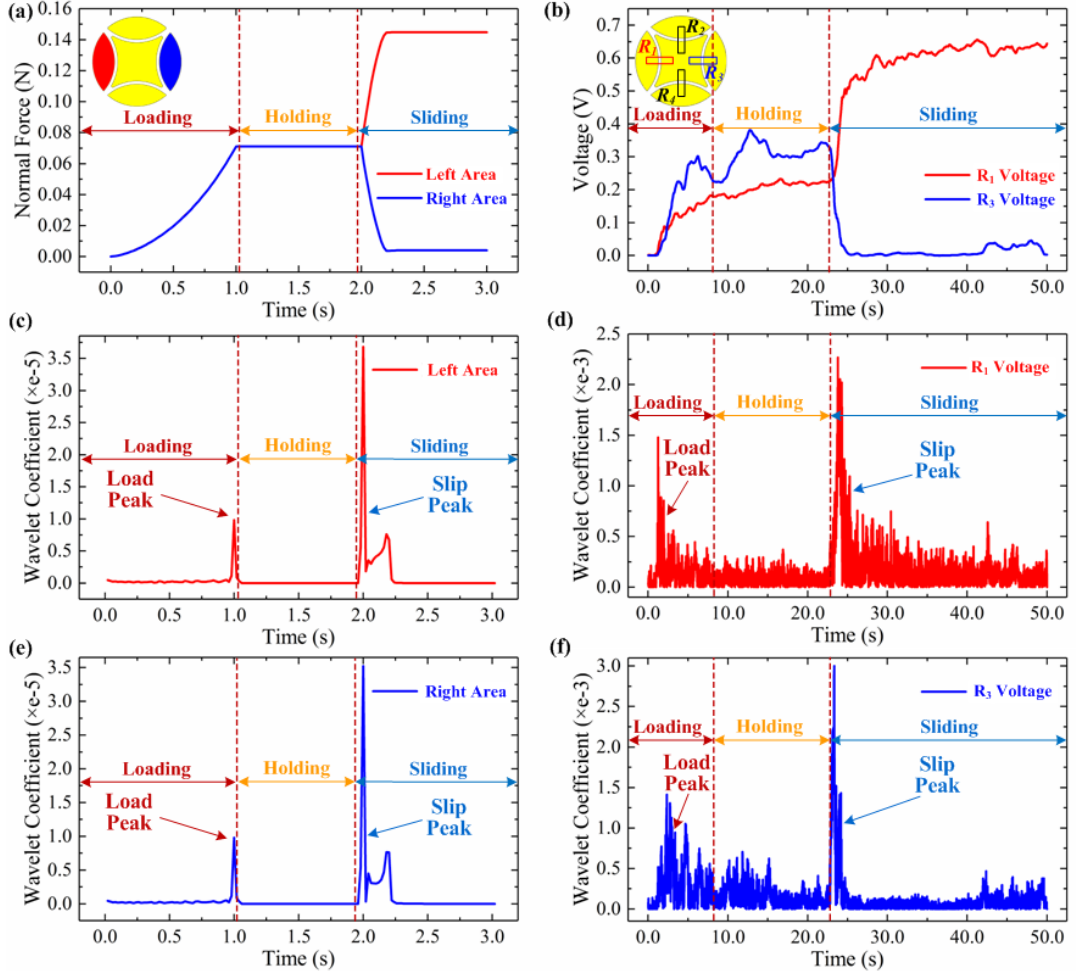
Figure 6. ( a ) Simulated normal force extracted from the left and right area of the patterned electrodes in the sensing unit ( b ) Measured voltages of R 1 and R 3 when sliding along a flat surface, DSWT analysis of the simulated normal force in left area ( c ) and right area ( e ) DSWT analysis of the measured voltages in R 1 ( d ) and R 3 ( f ).